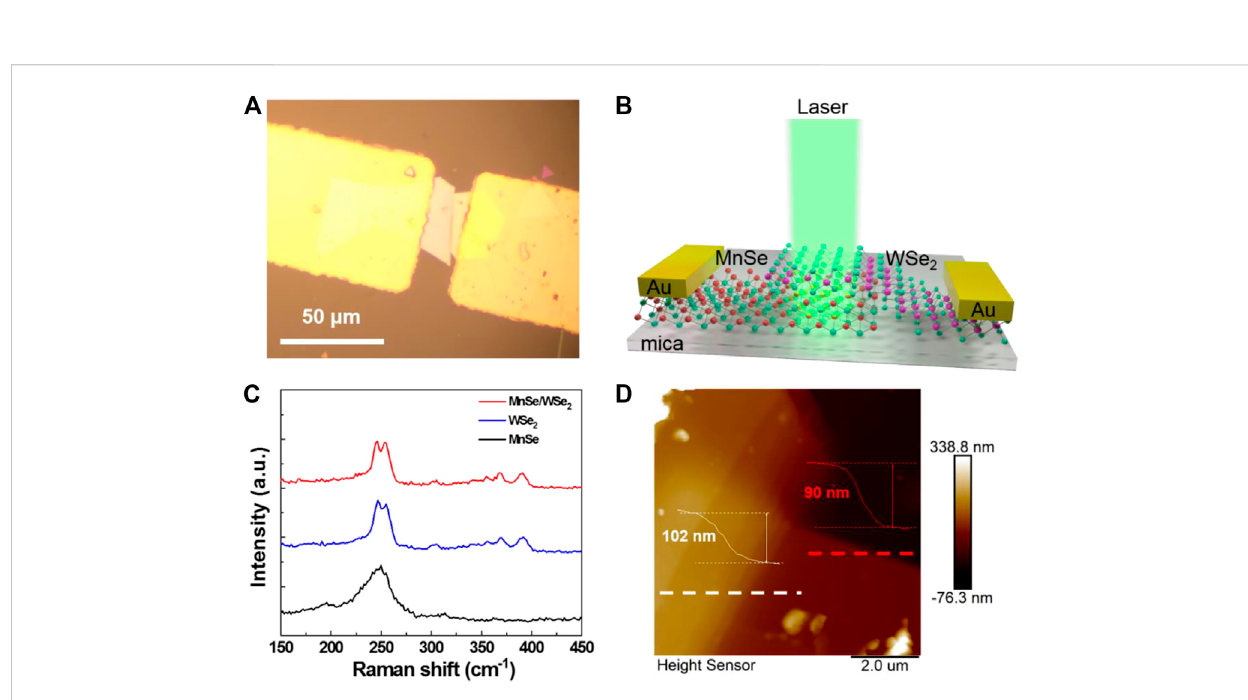
FIGURE 2 (A) The optical microscope image and (B) the schematic diagram of the MnSe/WSe 2 heterostructure. (C) The Raman spectra of MnSe, WSe 2 and